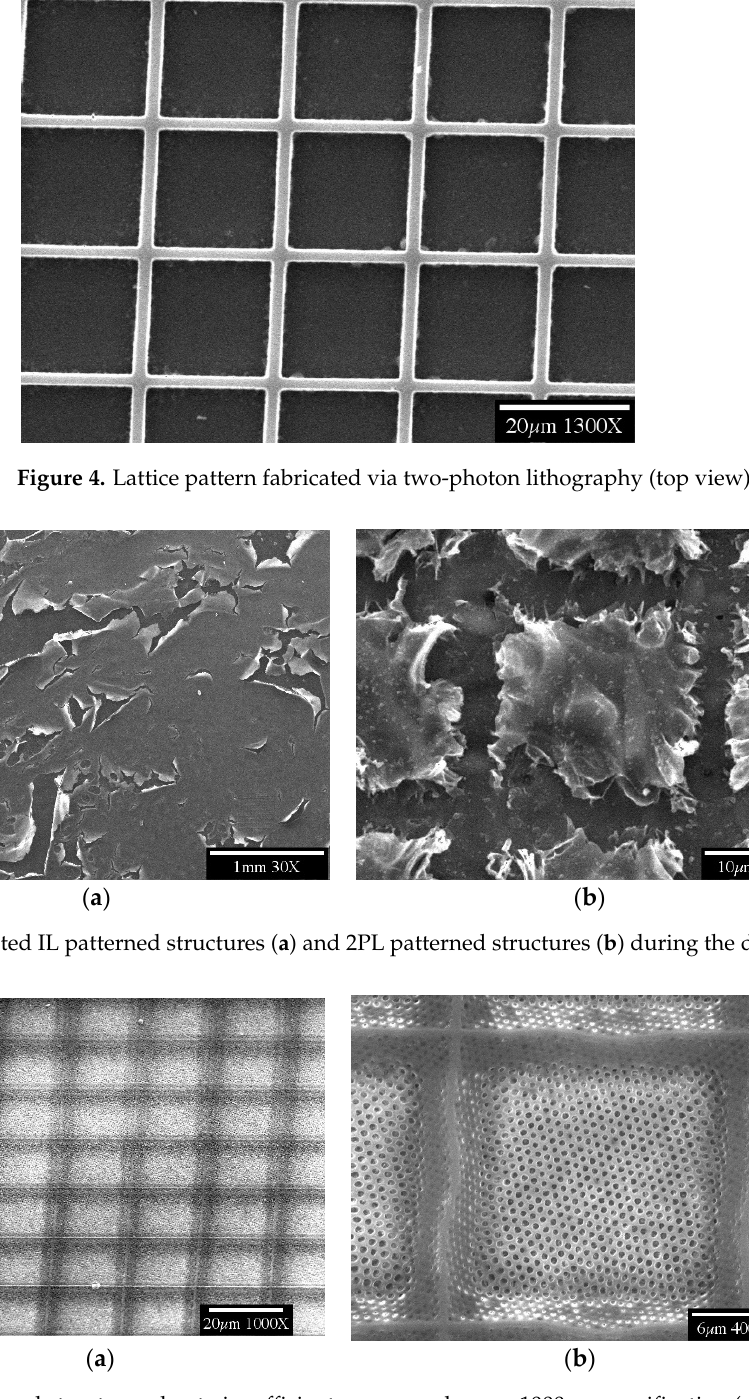
Figure 6. Collapsed patterned structures due to insufficient exposure dosage, 1000× magnification ( a ), 4000× magnification ( b ).